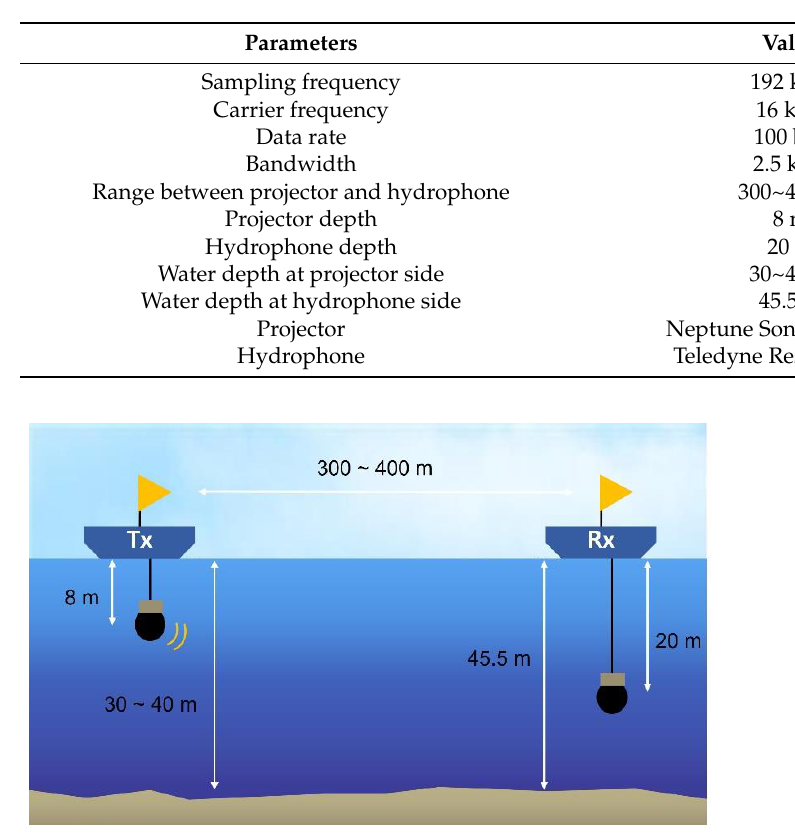
Figure 7. Configuration for the lake trial .